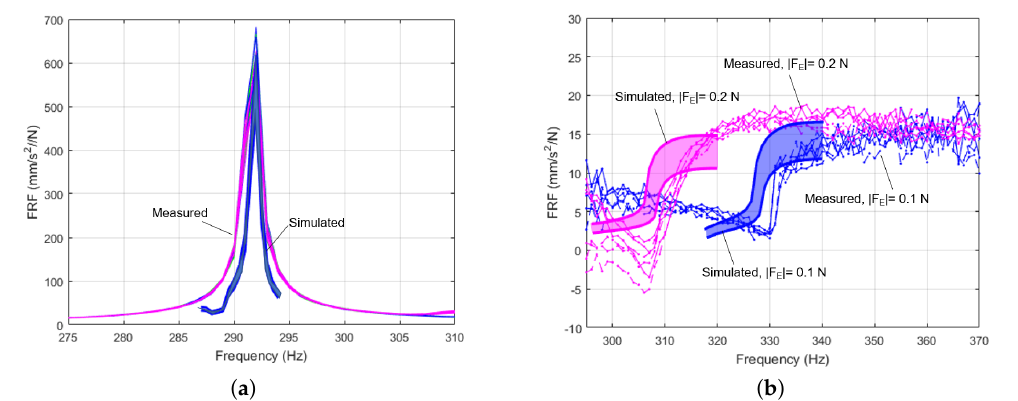
Figure 10. ( a ) IP and ( b ) OOP FRFs for different excitation levels, experimental numerical comparison for different values of | F E |